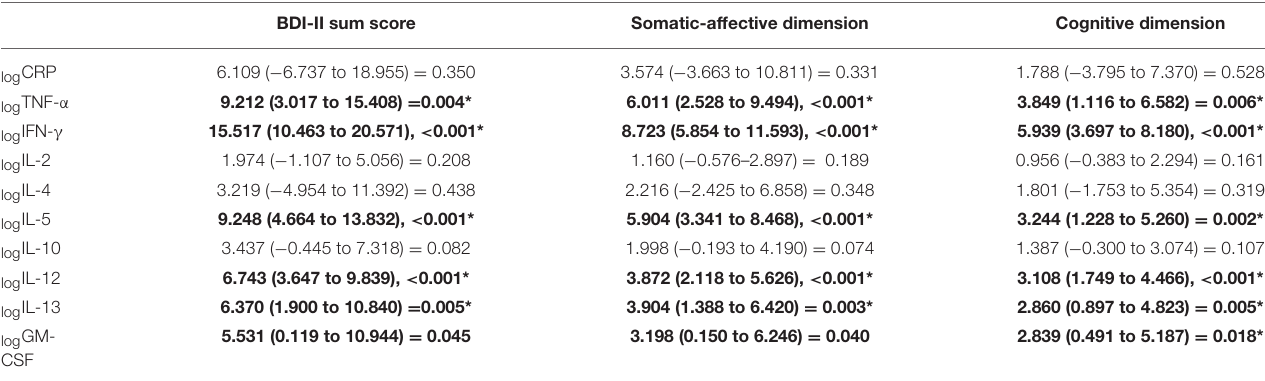
TABLE 3 | Regression analyses between inflammatory agents and dimensions of